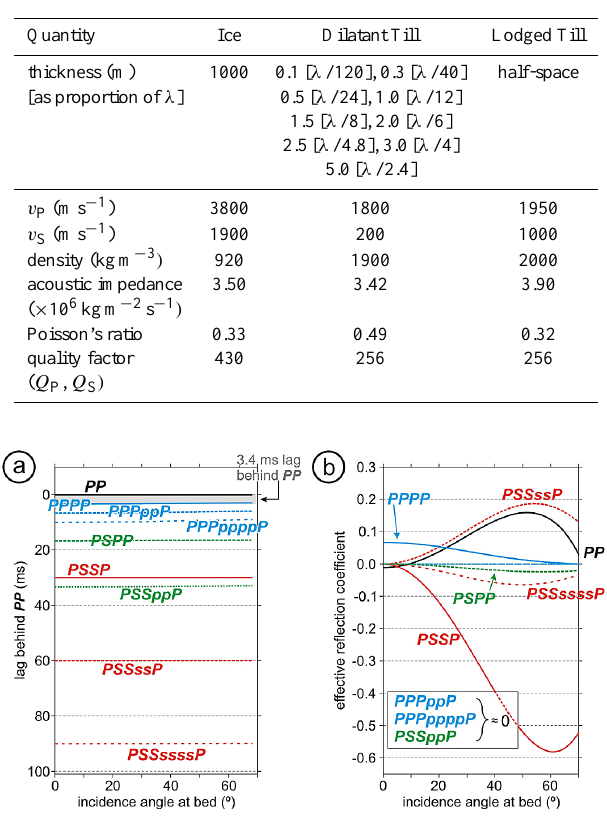
Fig. 3. Travel-time and effective reflectivity for model ray paths, as introduced in Fig. 2. (a) Ray-traced travel-times expressed, for clar- ity, as a lag behind PP. (b) Effective reflectivity of reflections in (a) . Ray paths that feature intrabed P-wave multiples have negligible